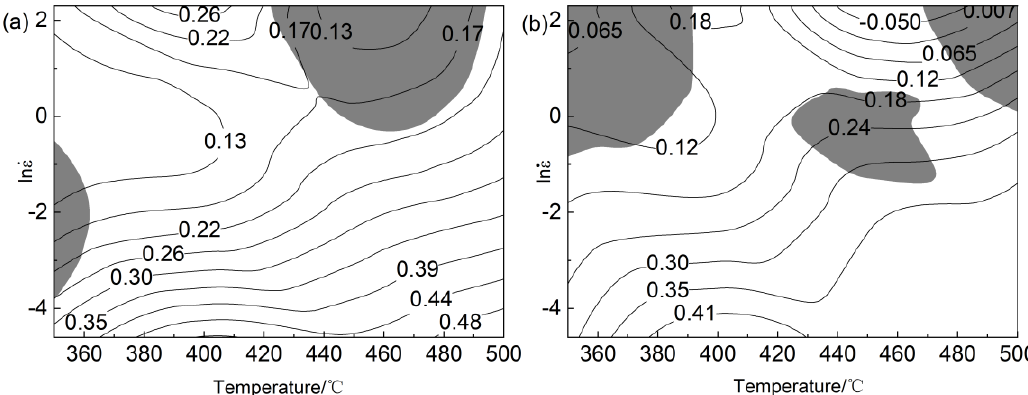
Figure 5. The processing maps of Al − Mg − Zn − Er − Zr alloy under different strains: ( a ) ε = 0.2; ( b ) ε = 0.5.